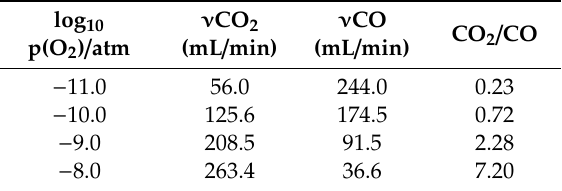
Table 2. The calculated oxygen partial pressures and used gas flow rates (T = 1300 ◦ C, P tot = 1